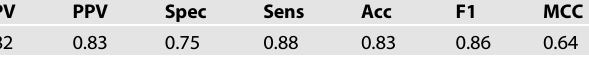
Table 4. Classi fi er performance measures for depression groups (mixed symptoms as